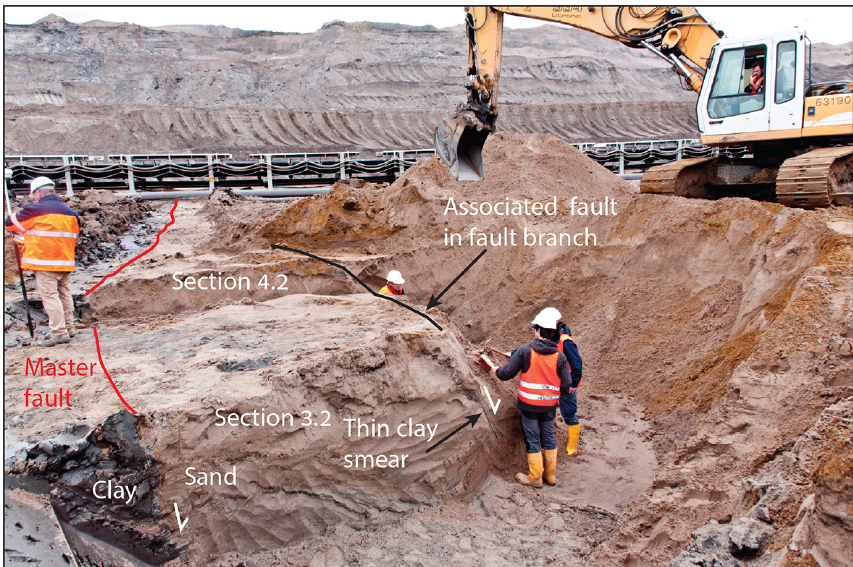
Figure 3. Overview showing the excavation side. The master fault is depicted in red, while a black line shows the associated synthetic fault at which the clay smears were excavated. Trenches 3 and 4 are